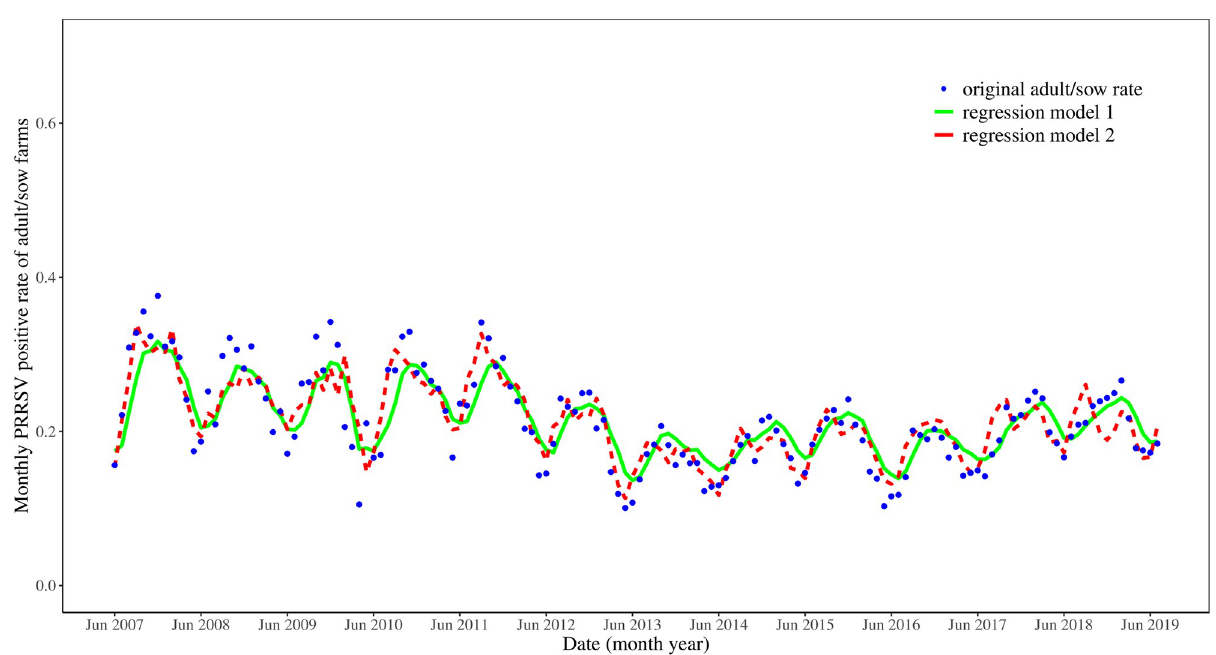
Fig 4. Regression models for the porcine reproductive and respiratory syndrome virus (PRRSV) positive rates in adult/sow farms.